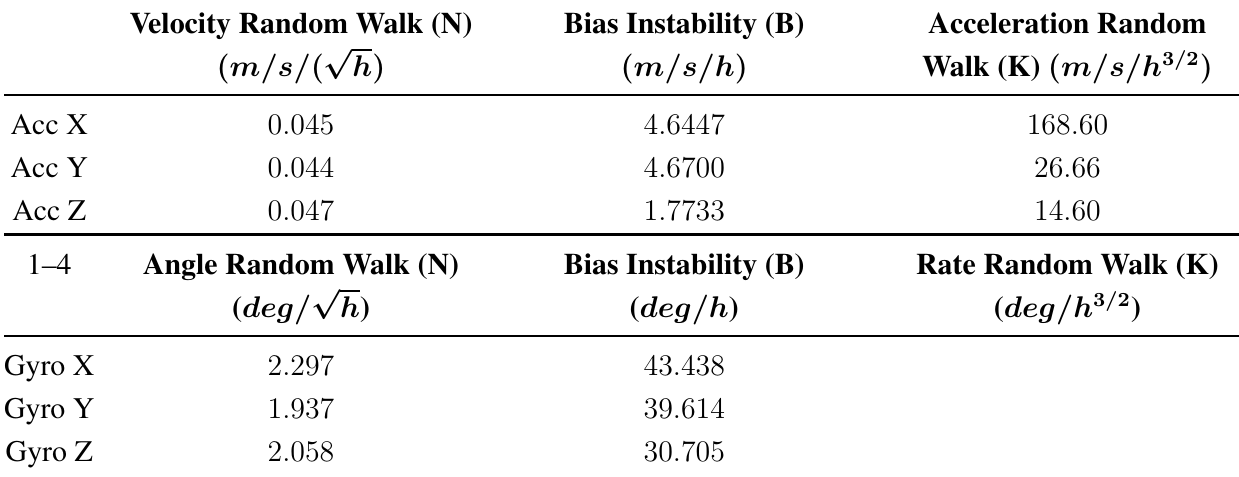
Table 3. Identified error coefficients for accelerometers and gyro of the 3DM-GX3 IMU with